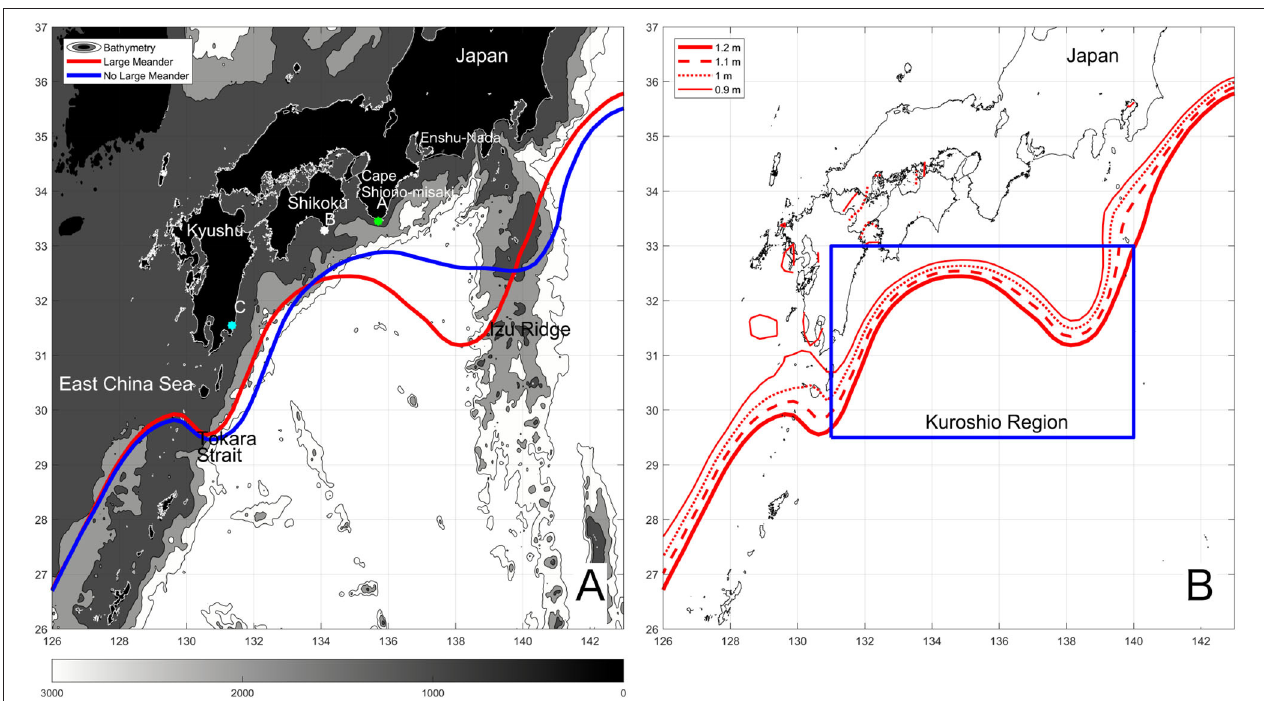
FIGURE 1 | (A) Bimodal paths of the Kuroshio for the No Large Meander (blue line) and the Large Meander (red line) paths. Contours are drawn for the bathymetry with an interval of 1,000 m. (B) The Kuroshio axes during the LM defined with the different definitions with SSH values at 1.2, 1.1, 1, and 0.9 m. The blue box represents the Kuroshio region, in which the path length, chlorophyll-a, mixed layer depth, and wind stress are extracted along the Kuroshio